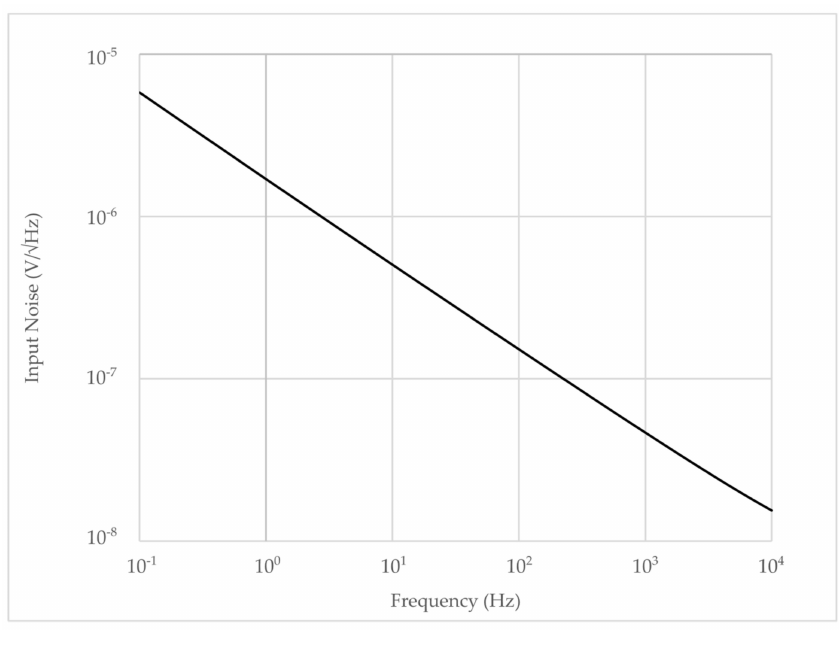
Figure 10. Input-referred noise performance of the amplifier.